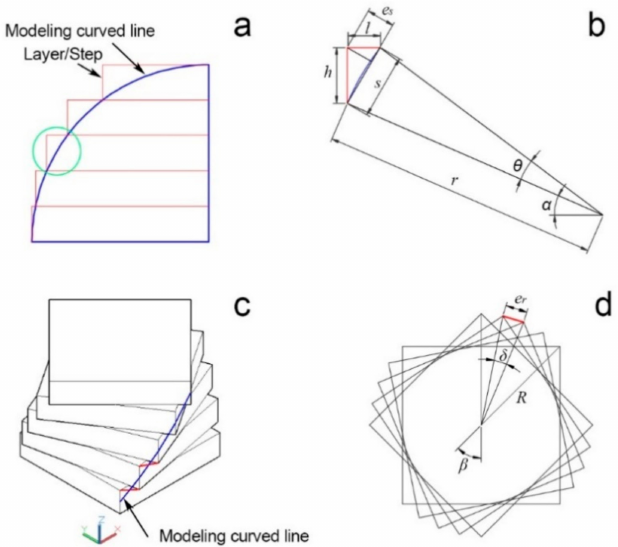
Figure 5. ( a ) Theoretical manufacturing error between contours of the modeling curve line and LcVL layer stacking; ( b ) Calculation parameters for the theoretical manufacturing error from LcVL layer stacking; ( c ) Theoretical manufacturing error between contours of the modeling curve line and postrotation LcVL layer stacking; ( d ) Calculation parameters for the theoretical manufacturing error from postrotation layer